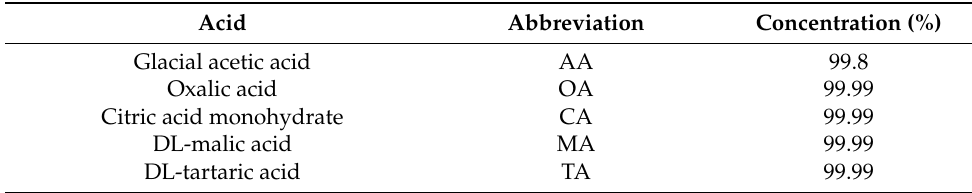
Table 1. Abbreviations and concentration of the five low molecular weight organic acids (Shanghai Aladdin Biochemical Technology Co., Ltd., Shanghai, China). Acid Abbreviation Concentration (%) Glacial acetic acid AA 99.8 Oxalic acid OA 99.99 Citric acid monohydrate CA 99.99 DL-malic acid MA 99.99 DL-tartaric acid